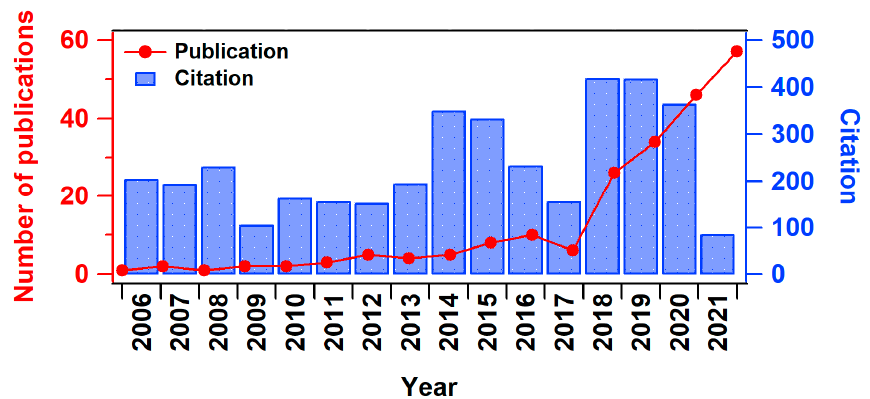
Figure 1. Number of reported publications on magnetron-sputtered HEFs. The histogram shows the number of the articles from 2006 to December 2021. The red curve displays the citation number of the articles per year. The results are plotted according to statistical analysis from the Scopus website.